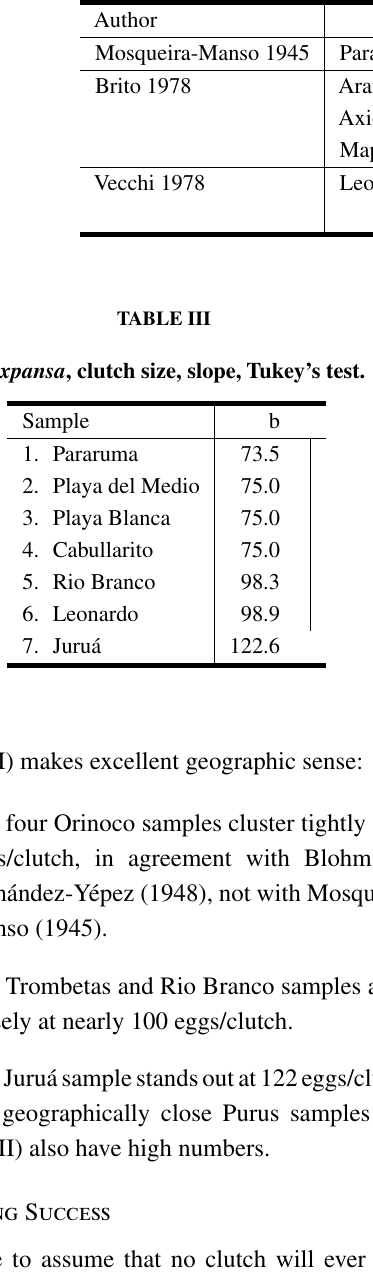
eggs/clutch, in agreement with Blohm and Fernández-Yépez (1948), not with Mosqueira- Manso